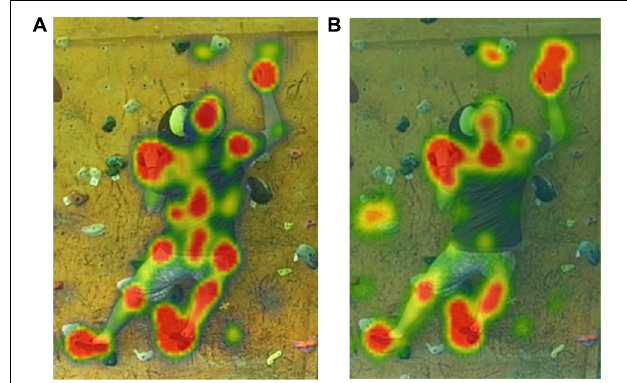
TABLE 1 | Organization of data codes from the thematic